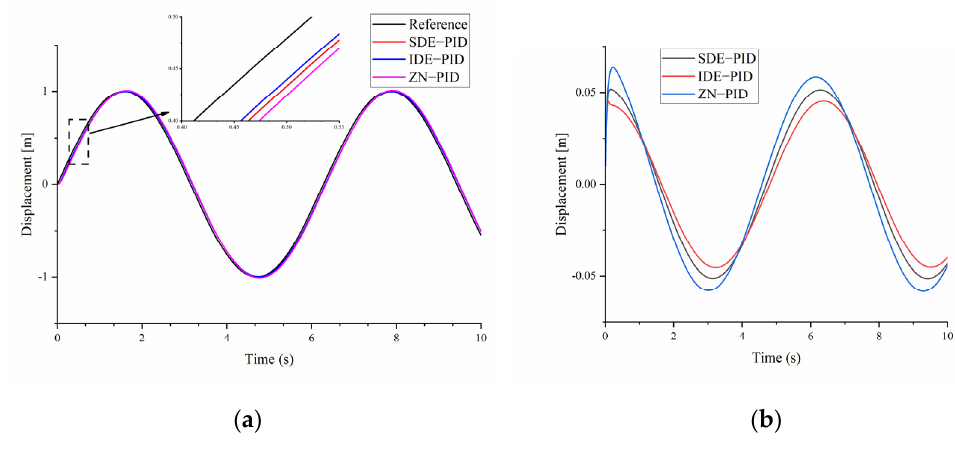
Figure 11. ( a ) Comparisons of sinusoidal responses and ( b ) tracking errors.